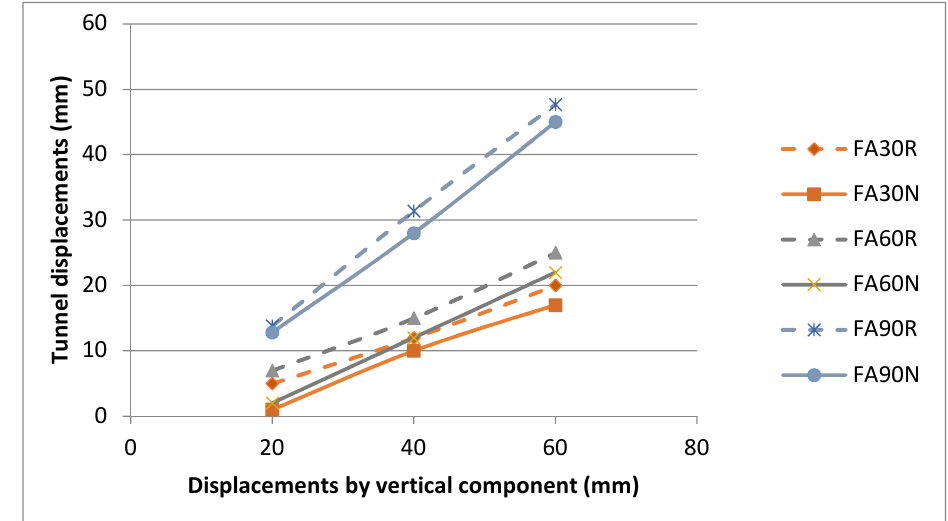
Figure 10. Fault angles of 30°, 60°, and 90° in normal and reverse faults.